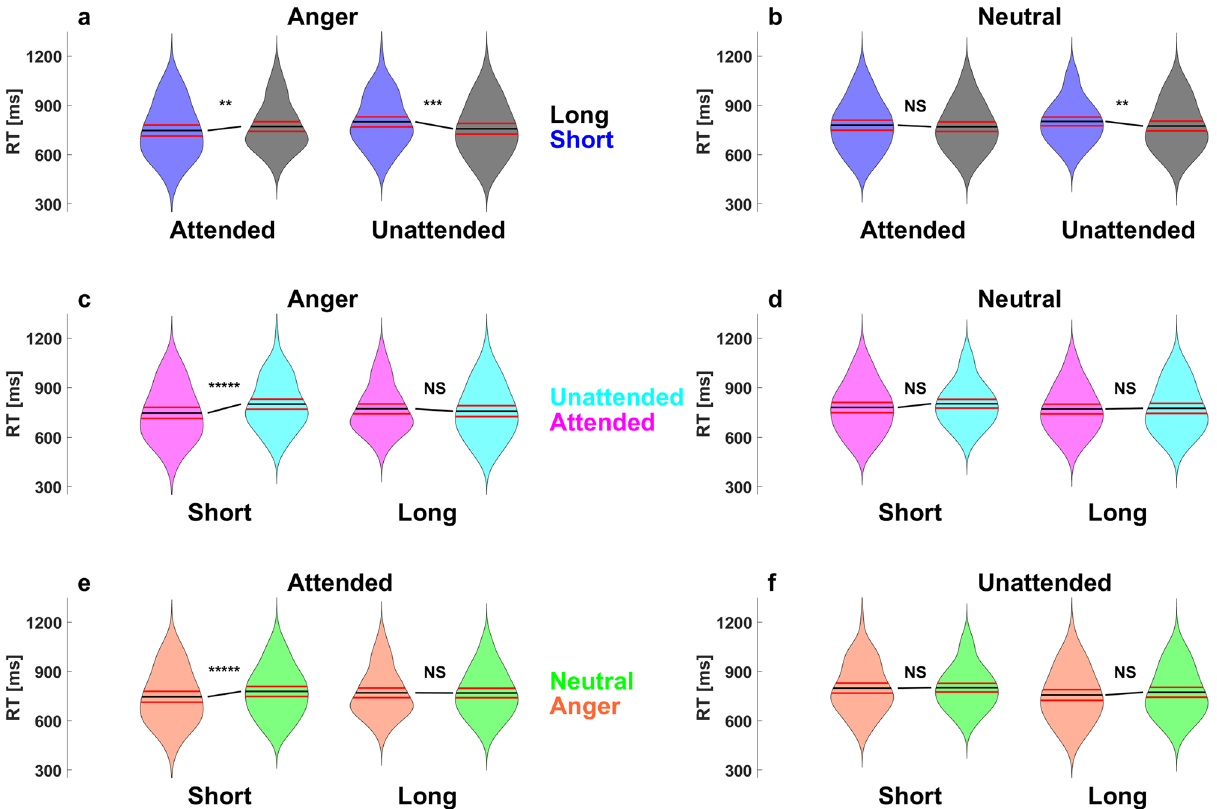
Figure 2. Emotional specific temporal attentional biases in emotional prosody perception in response time. Violin plots of responses time depending on the factors cue, attention and emotion. Cues differences between short (in blue) and long (in grey) trials (Top), for angry voices left and for neutral voices right, depending on the attentional factor (attended and unattended; a – b ). Attentional differences between attended (in magenta) and unattended (in cyan) trials (Middle), for angry voices left and for neutral voices right, depending on the target stimulus onset factor (short and long; c – d ). Emotional differences between angry (in orange) and neutral voices (in green) trials (Bottom), for attended voices left and unattended voices right, depending on the target stimulus onset factor (short and long; e – f ). Note here that the raw results are presented in Table S1. The black line on the violin plot indicate the averaged value and the red lines the Confidence Interval at 95%. The star above this line indicate the statistical significance for each tests, with ***** indicating a Bonferroni corrected p value below < 0.00001, **** < 0.0001, *** < 0.001, ** < 0.01, * < 0.05 and NS stands for statistically non-significant